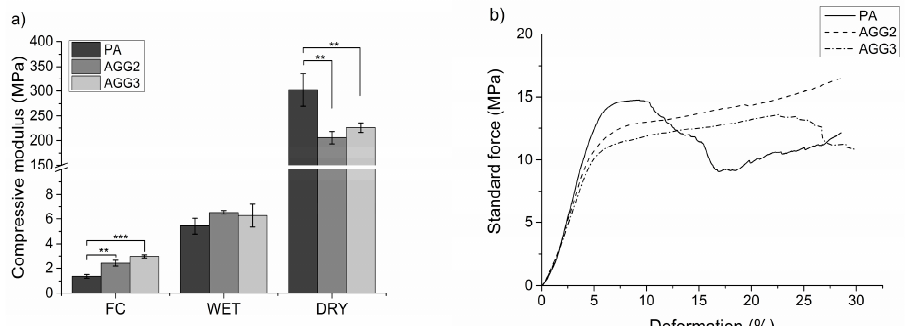
Figure 6. Young’s moduli of ( a ) freshly crosslinked (FC) scaffolds, scaffolds in re-swollen state (WET) after freeze drying and in dry state (DRY) after freeze drying (mean ± SD; n = 5; ** p < 0.005, *** p <0.001); ( b ) Representative stress strain curves of PA and composite scaffolds in dry state.